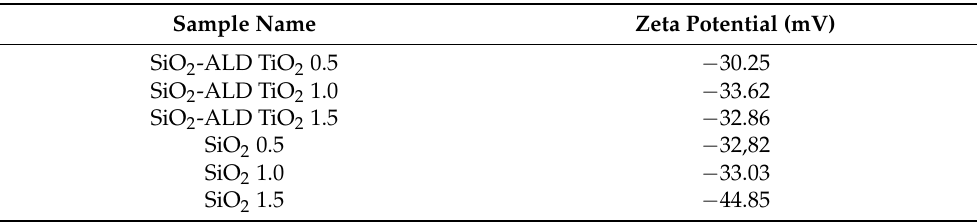
Table 6. Average zeta potential values of the different nanofluids.